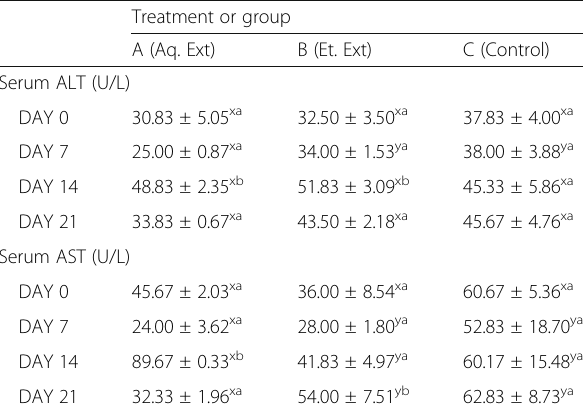
Table 2 Serum ALP and LDH of normal rabbits treated with extracts of Acalypha wilkesiana leaves Treatment or group